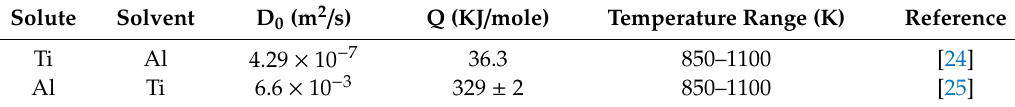
Table 2. Assessed Arrhenius parameters for impurity diffusion coefficients in liquid Al.